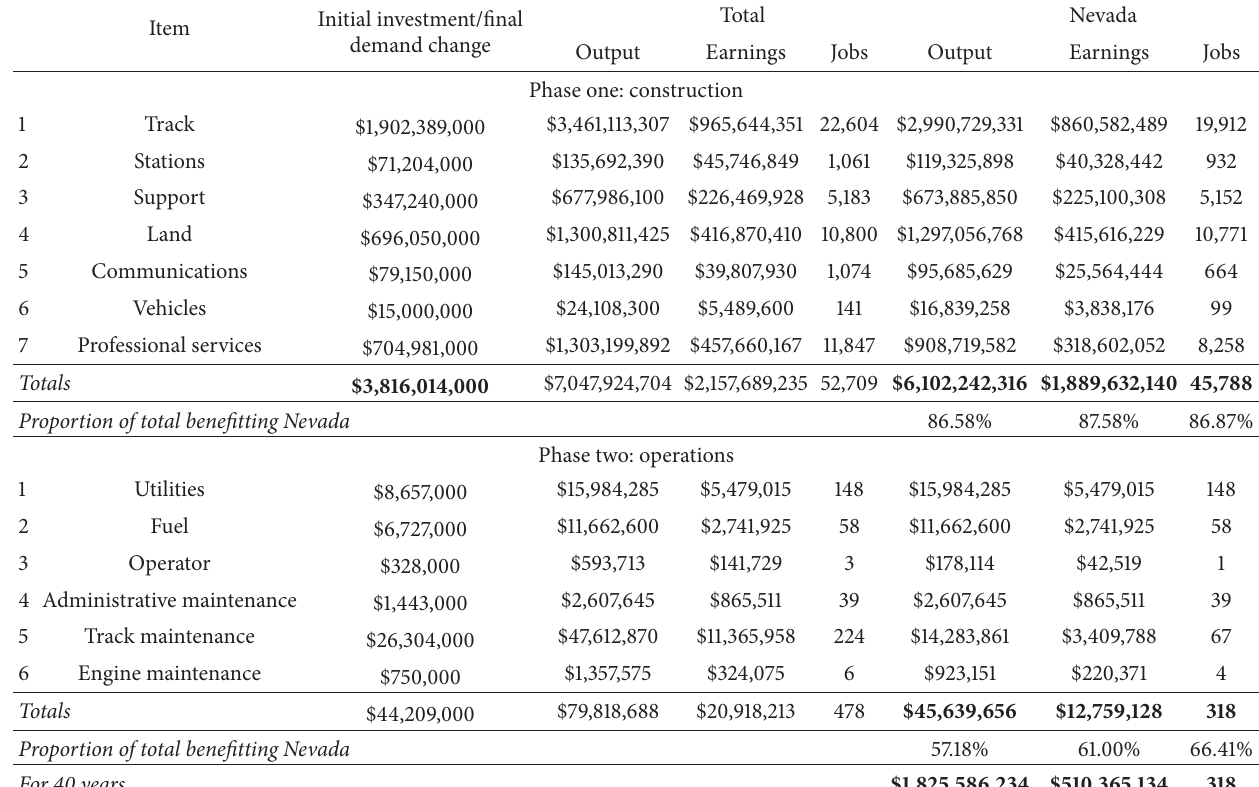
Table 1: Results of the economic impact